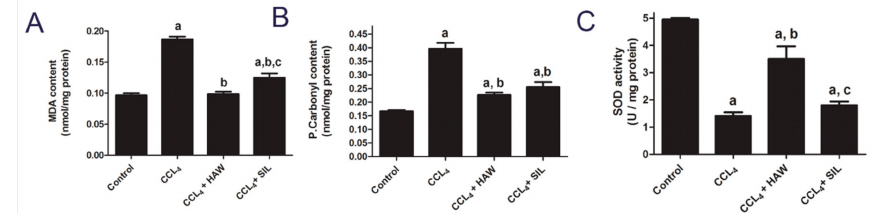
Figure 5. HAW inhibited oxidative stress markers in rats. ( A ) malondialdehyde (MDA) content ( B ) P.Carbonyl content and ( C ) superoxide dismutase (SOD) activity in liver tissues. Data are presented as means ± SEM ( n = 6 in each group). a is p < 0.05 vs. control group, b is p < 0.05 vs. CCl4 group, and c is p < 0.05 vs. HAW